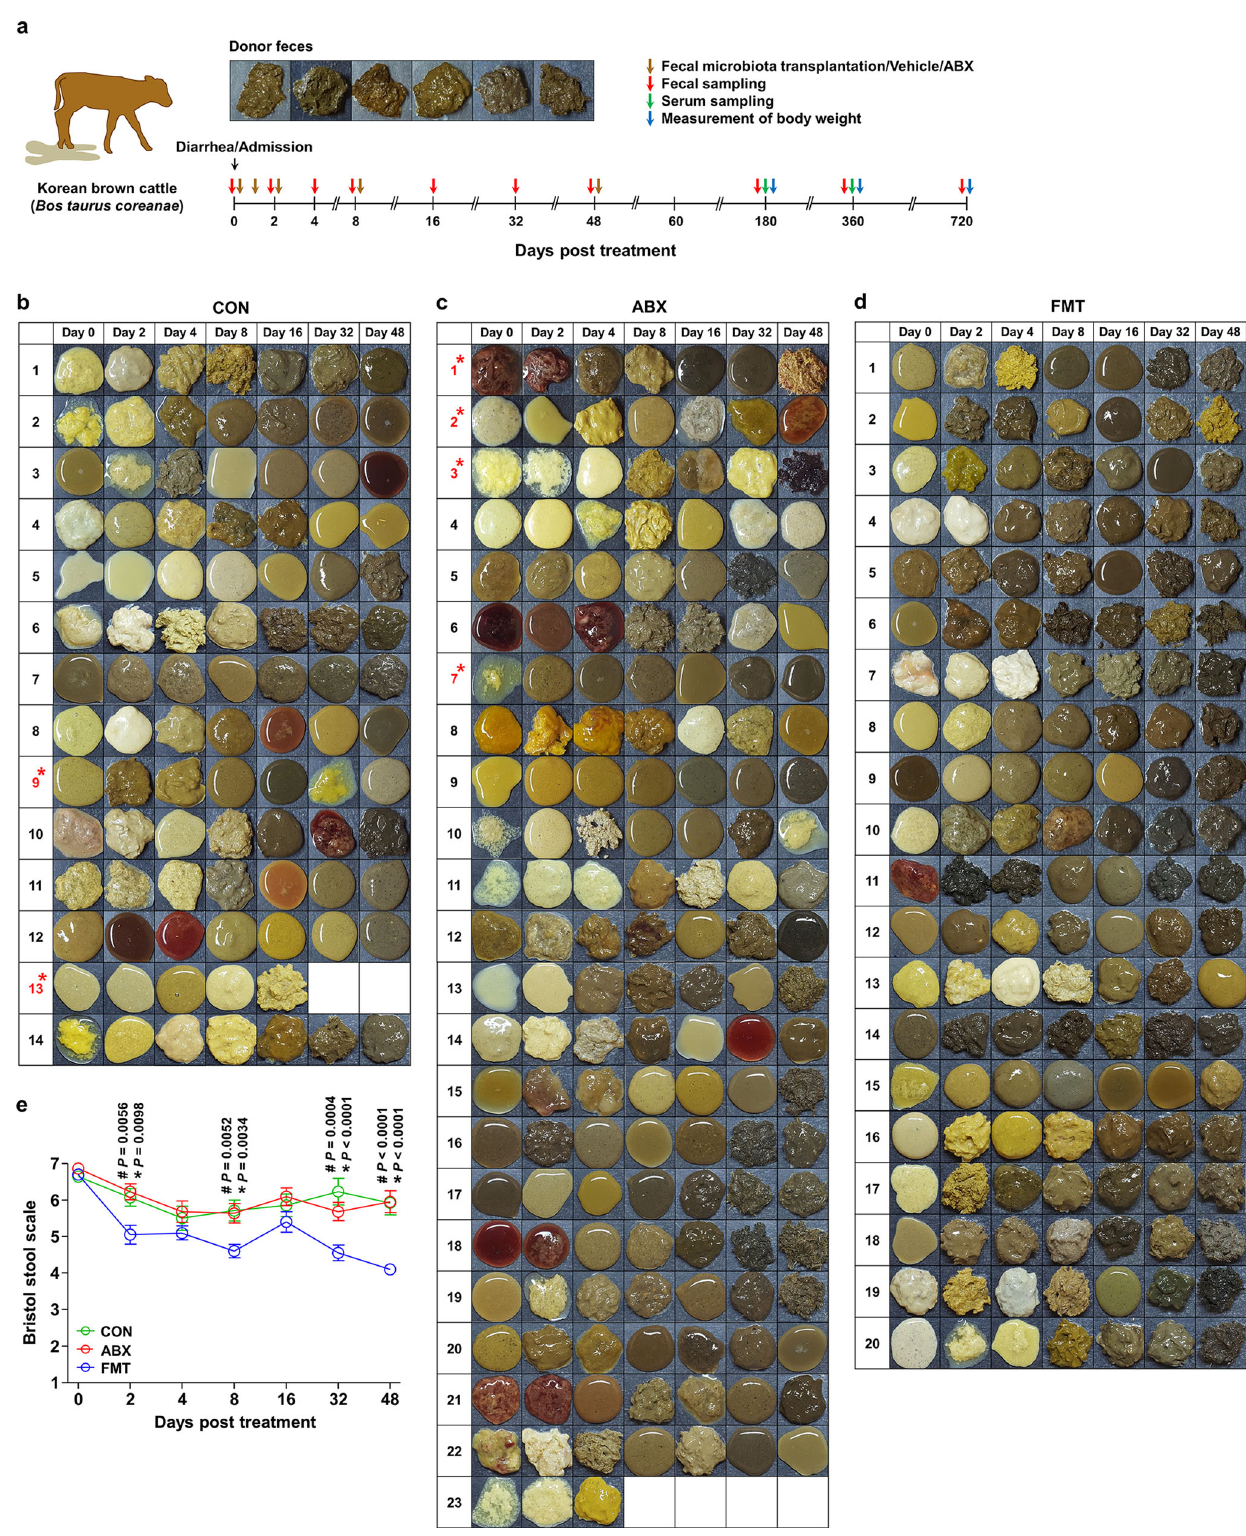
Fig. 1 Design of the FMT trials and the effect of the treatment on the incidence of diarrhea. a Design of the FMT trial in calves with diarrhea. A detailed description is provided in the Methods section. b – d Images of the fecal samples collected from the recta of CON ( b , n = 14), ABX ( c , n = 23), and FMT ( d , n = 20) calves 0, 2, 4, 8, 16, 32, and 48 days after the treatments commenced. A red asterisk indicates a calf that died. e The incidence of diarrhea is represented by the BSS of the fecal samples collected from CON ( n = 14), ABX ( n = 23), and FMT ( n = 20) calves. The BSSs for the CON, ABX, and FMT groups are shown in green, red, and blue, respectively. Data are shown as mean ± SEM. The P values were determined using the Mann – Whitney U test (two-tailed). *Comparison of the CON and FMT groups; # comparison of the ABX and FMT groups; and † comparison of the CON and ABX groups. CON control, ABX antibiotic, FMT fecal microbiota transplantation, BSS Bristol stool scale. Source data are provided as a Source Data fi le.